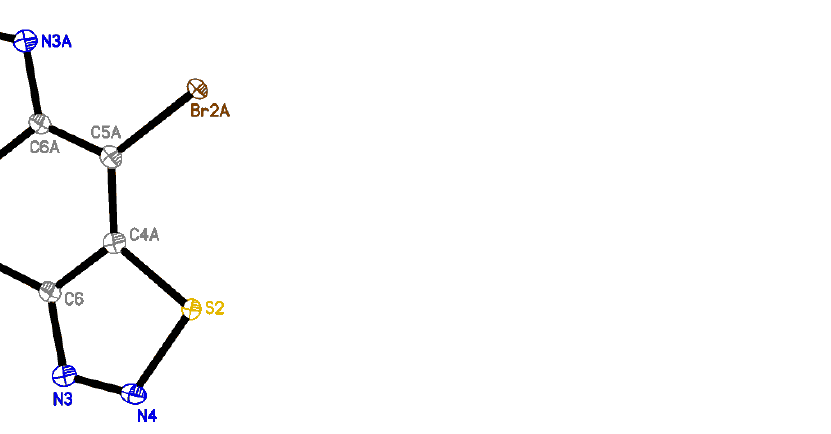
Figure 2. The general view of 4,8-dibromobenzo[1,2- d :4,5- d ’ ]bis([1,2,3]thiadiazole) 1 in a representation of atoms by thermal ellipsoids ( p = 50%).